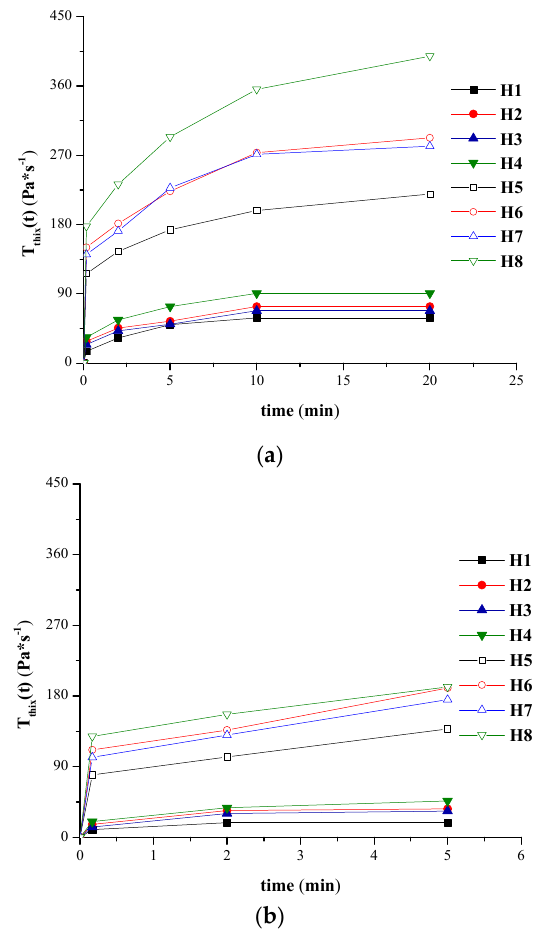
Figure 5. ( a ) Thixotropy area values vs. different stirring times at maximum rotational speed for hydrogels H1–H8 analyzed at: ( a ) 23 °C; ( b ) 37 °C.